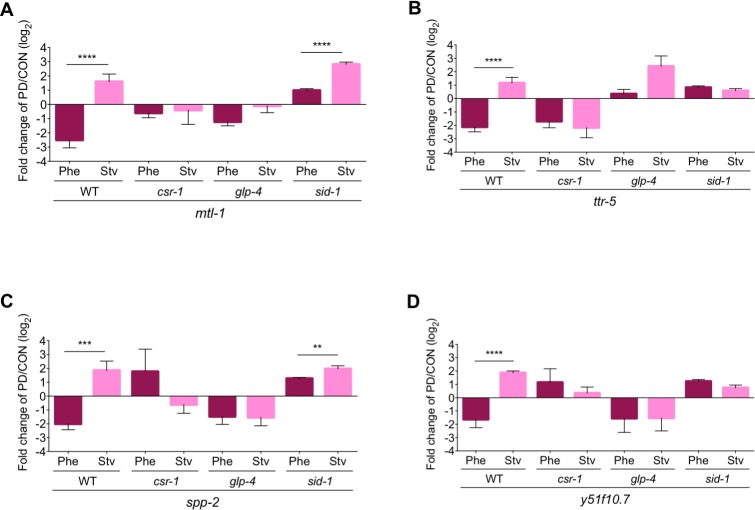
The germ line, SID-1, and CSR-1 are required for seesaw gene expression changes in the soma.(A-D) qRT-PCR validation of mRNA levels of soma-expressed, non-CSR-1 targeted seesaw gene PD/CON mRNA levels in WT, csr-1 hypomorph, glp-4(bn2) (grown at 25°C), and sid-1(qt9) strains for Phe and Stv conditions. ** p < 0.01, *** p < 0.001, **** p < 0.0001; Student’s t-test comparison of Phe (PDPhe/CONPhe) and Stv (PDStv/CONStv) within a strain. Error bars represent S.E.M. qRT-PCR validations for additional genes are found in S3, S4, S5 and S6 Figs.